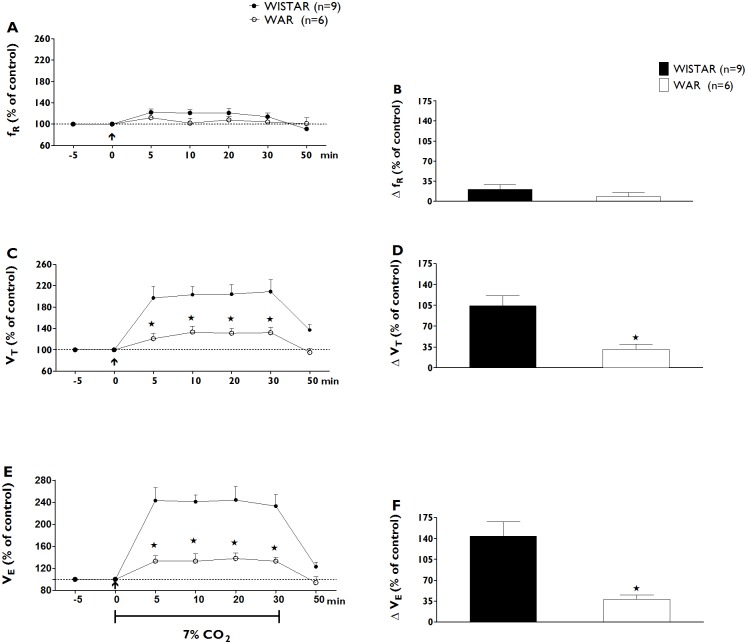
Changes in Respiratory Variables after Hypercapnia.Time-course of respiratory frequency (fR, % of control, A), tidal volume (VT, % of control, C) and minute ventilation (VE, % of control, C) changes during 30 min of hypercapnia (7% CO2) in Wistar (blue dots) and WAR groups (red dots). Peak changes in baseline respiratory frequency (ΔfR, % of control, B), tidal volume (ΔVT, % of control, D) and minute ventilation (ΔVE, % of control, F) 20 min after the beginning of hypercapnia (7% CO2) in Wistar (blue bars, n = 9) and WAR groups (red bars, n = 6). The arrow indicates the moment of the establishment of hypercapnia. Data shown are expressed as mean ± SEM. p<0.05, Two-way ANOVA followed by Bonferroni’s post-hoc test. (*) Significantly different from Wistar control group.